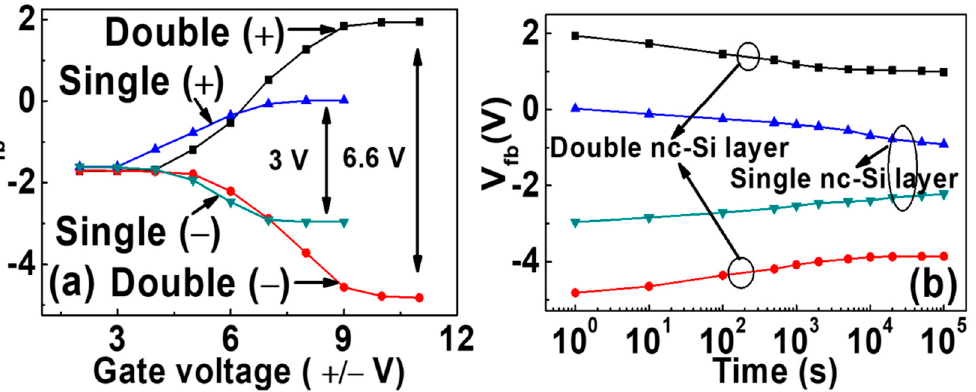
Figure 3. Flat-band voltage variation and the retention characteristics of the nc-Si floating-gate MOS structure with ( a ) single-layer nc-Si and ( b ) double-layer nc-Si.